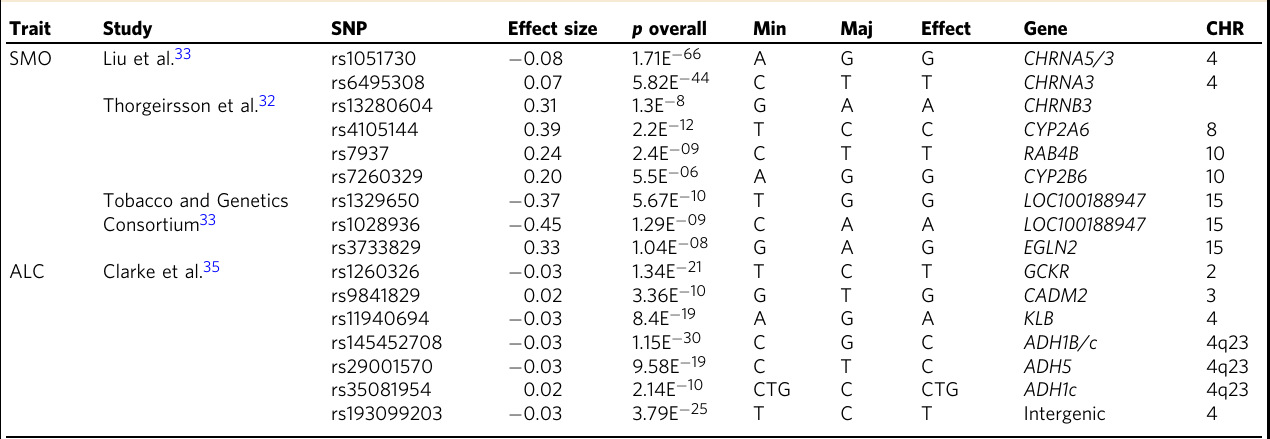
Table 3 Selected SNPs from GWAS of smoking and alcohol consumption Trait